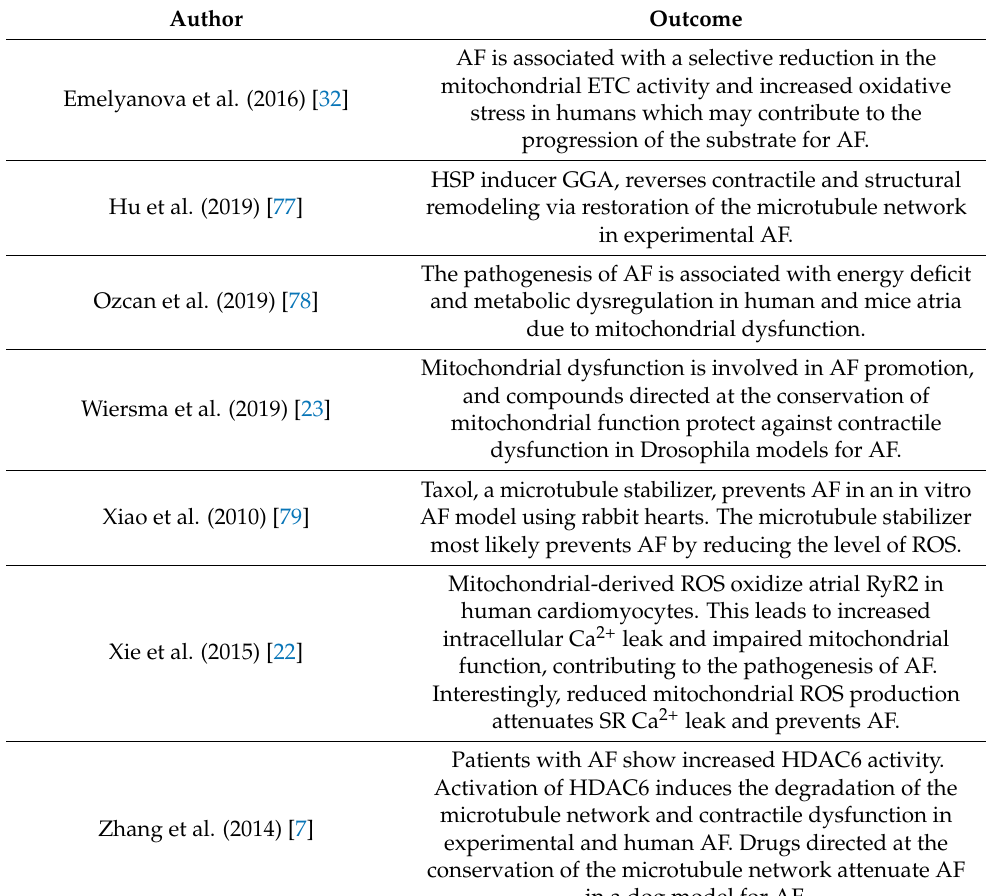
Table 1. Tubular view of current studies on mitochondrial dysfunction and